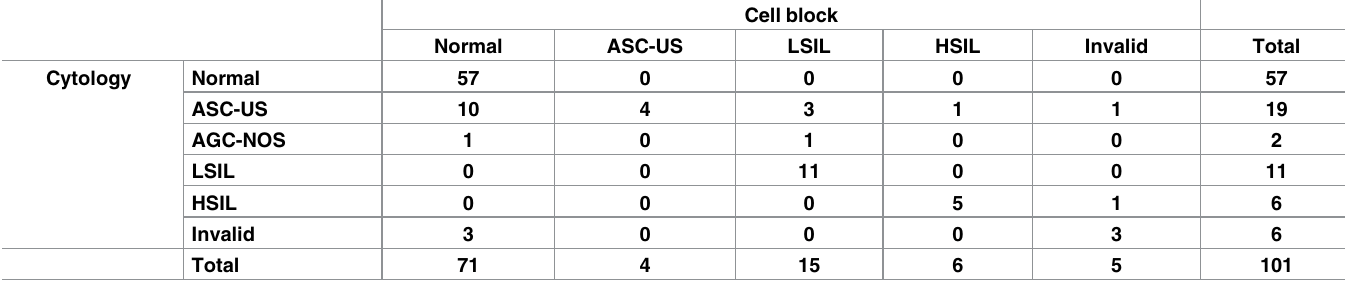
Table 5. Pathology agreementbetween cytology and cell block technique within ECB specimens (n =